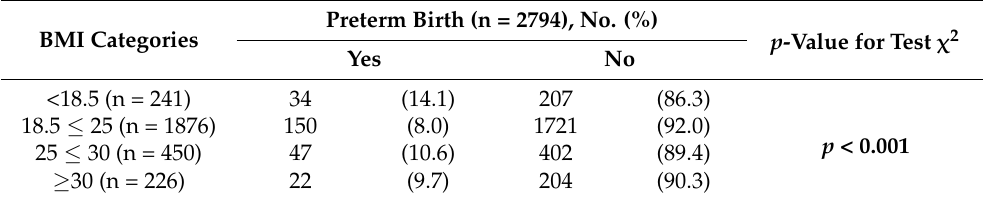
Table 3. The rates of preterm birth depending on early pregnancy BMI.